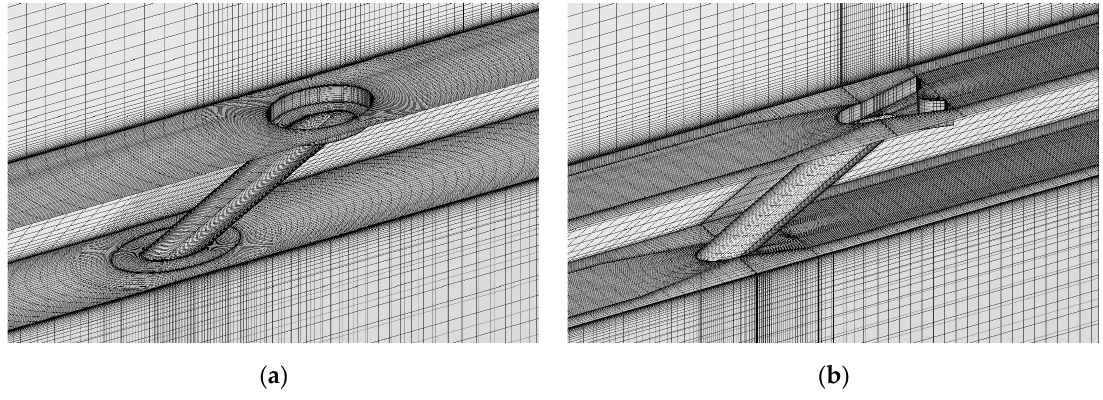
Figure 3. Computational grids. ( a ) the CIR_CRA model; ( b ) the CRA1 model.